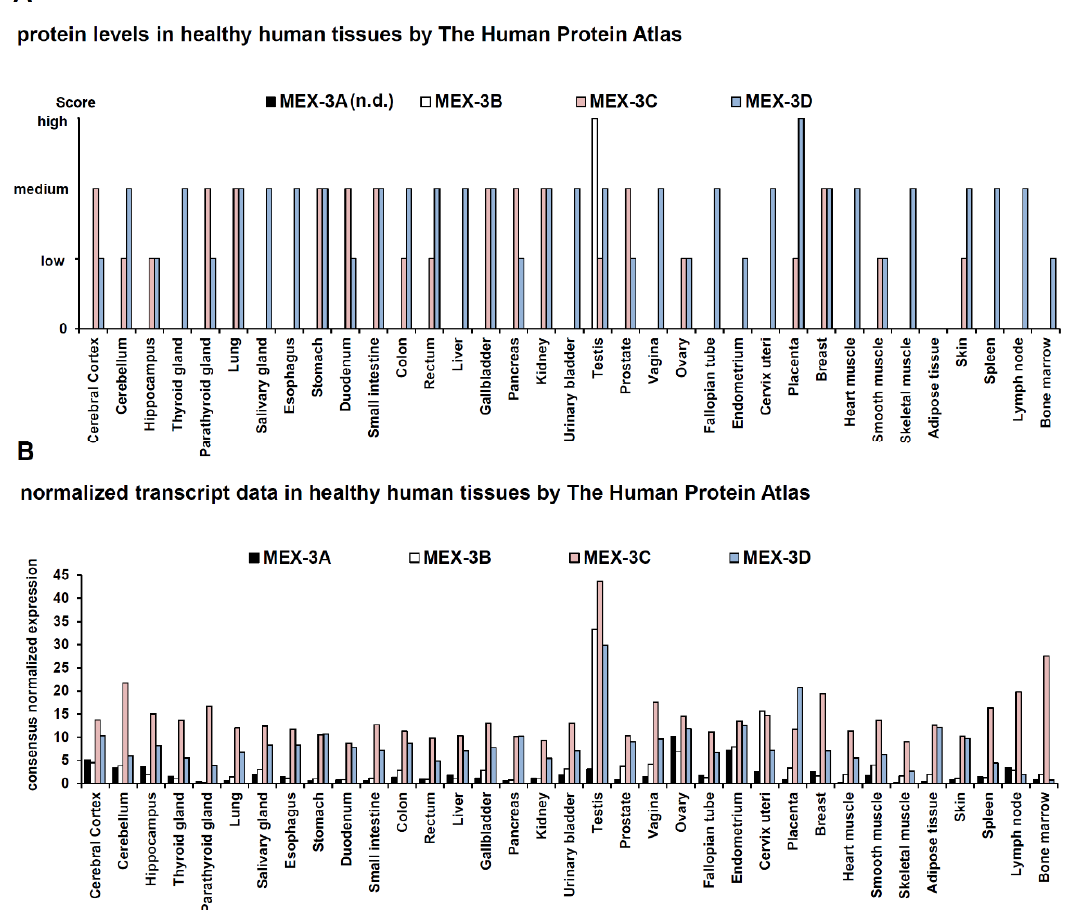
Figure 1. Protein and mRNA levels of MEX-3A-D in healthy human tissues of distinct origin. The protein ( A ) and mRNA ( B ) levels of the MEX-3A-D in selected healthy human tissues are expressed as bar diagrams based upon the data sets of The Human Protein Atlas [20–22]. Protein data for MEX-3A were not available. The protein levels were scored using immunohistochemistry data and the mRNA data are expressed as consensus normalized expression levels created by combining the data from the three transcriptomics datasets (HPA, GTEx, and FANTOM5) using an internal normalization.